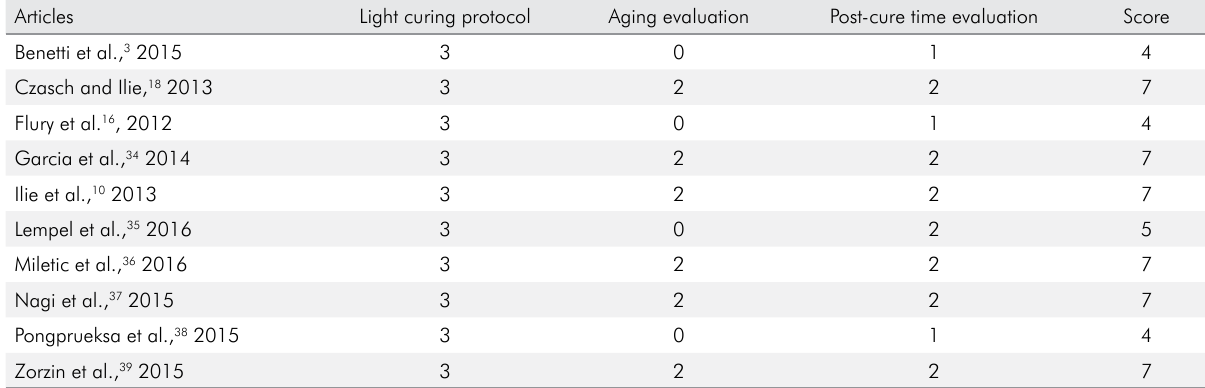
Table 5. Quality assessment scores concerning study design: methodological soundness (maximum score = 8 points).